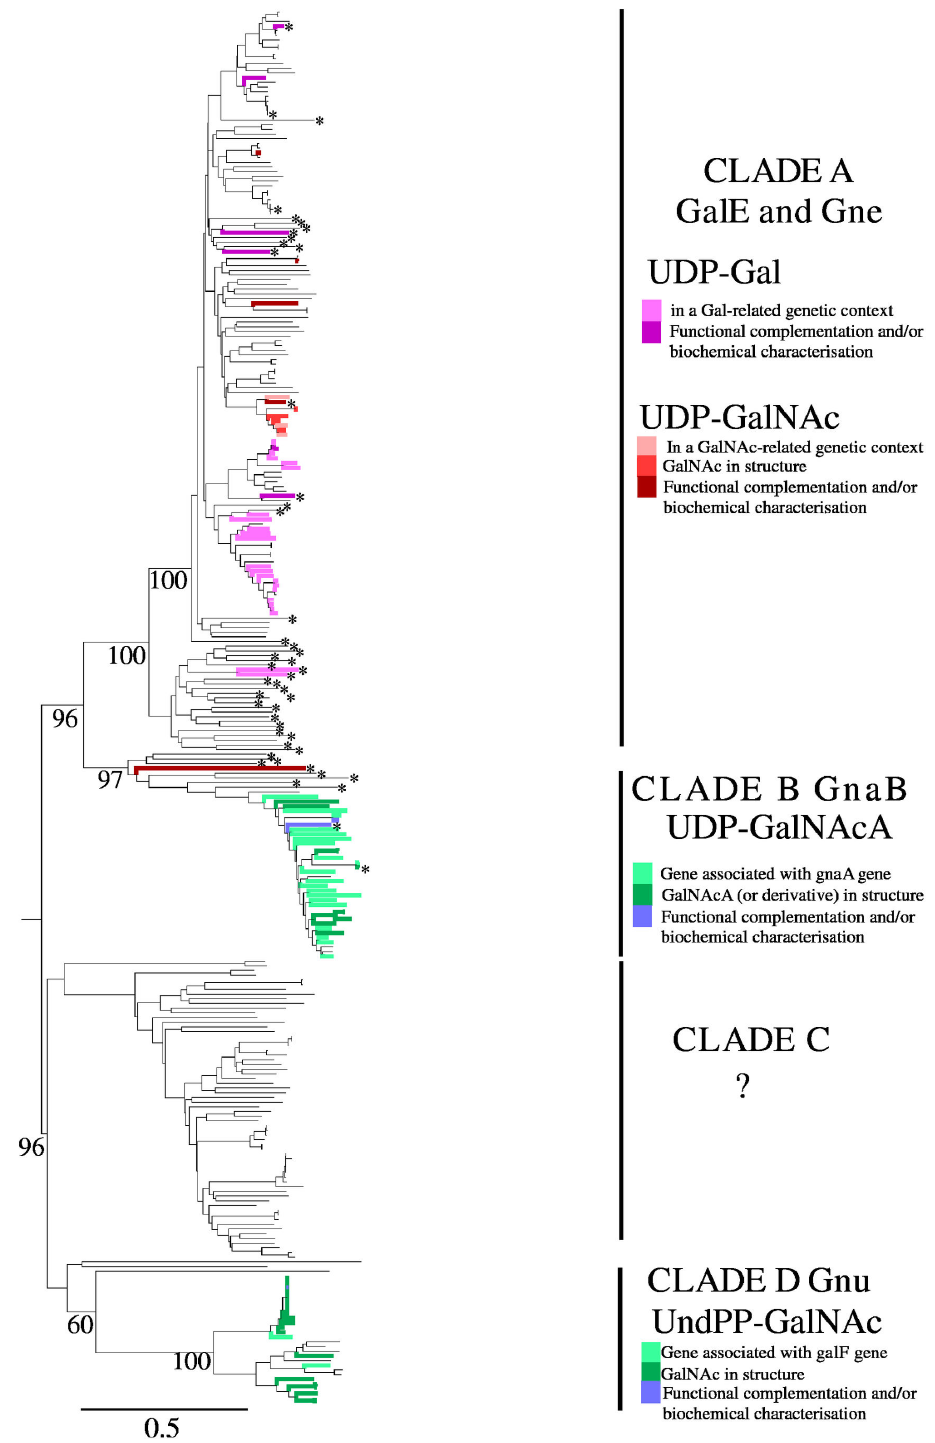
Figure 1. Tree of Gne and related proteins in the Gammaproteobacteriaceae and other selected species as found by genome BLAST or taken from the literature as described in the text and listed in Table S1. The tree is based on that shown in Figure S1 in which all of the strains are named. The four major clades are shown with branches coloured where additional information is available as indicated to the right of the Figure and in the text. The proteins indicated by an asterisk were from the Ishiyama et al (16) study. doi: 10.1371/journal.pone.0067646.g001 PLOS ONE |